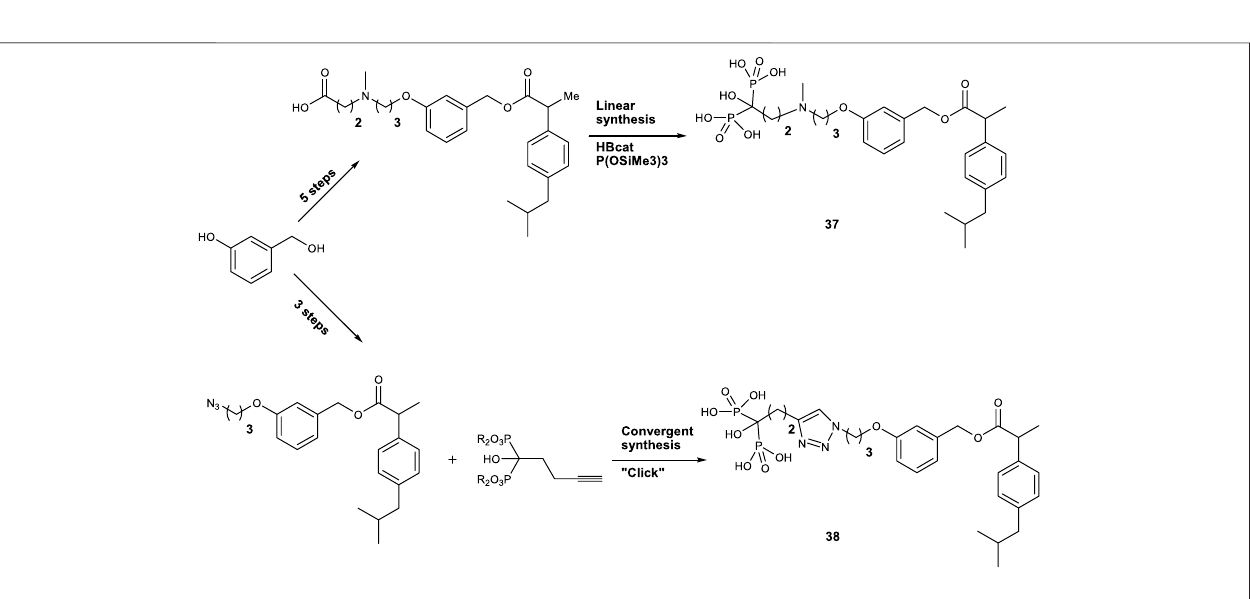
FIGURE 8 | Synthesis of 37 and 38 as bone-targeting compounds.